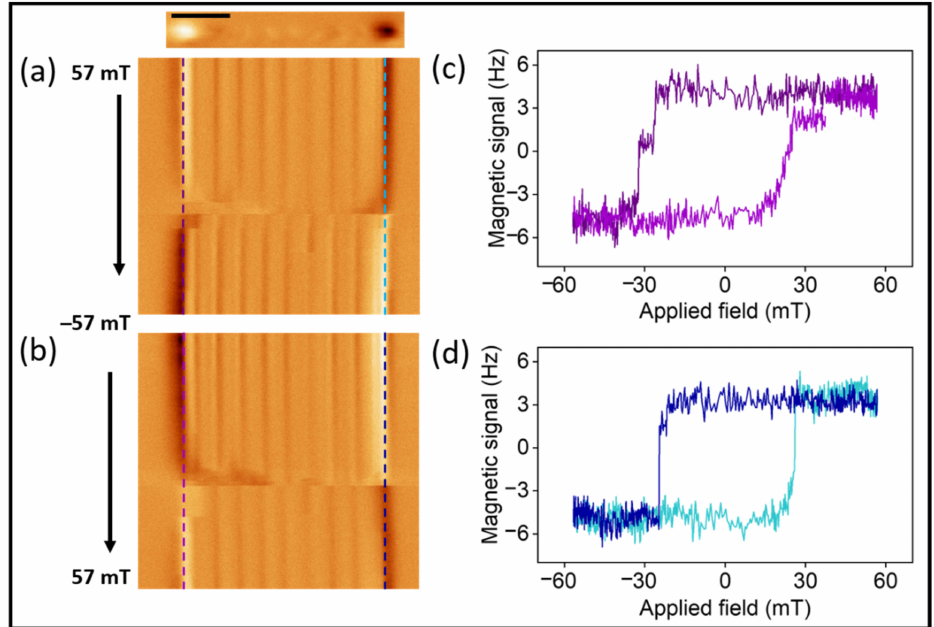
Figure 3. ( a , b ) The 2D modes MFM images corresponding to NW measured by MFM in top panel of ( a ). Scale bar is 2 µ m. The reconstructed hysteresis curves (measured along the profiles marked in ( a , b )) are presented in ( c , d